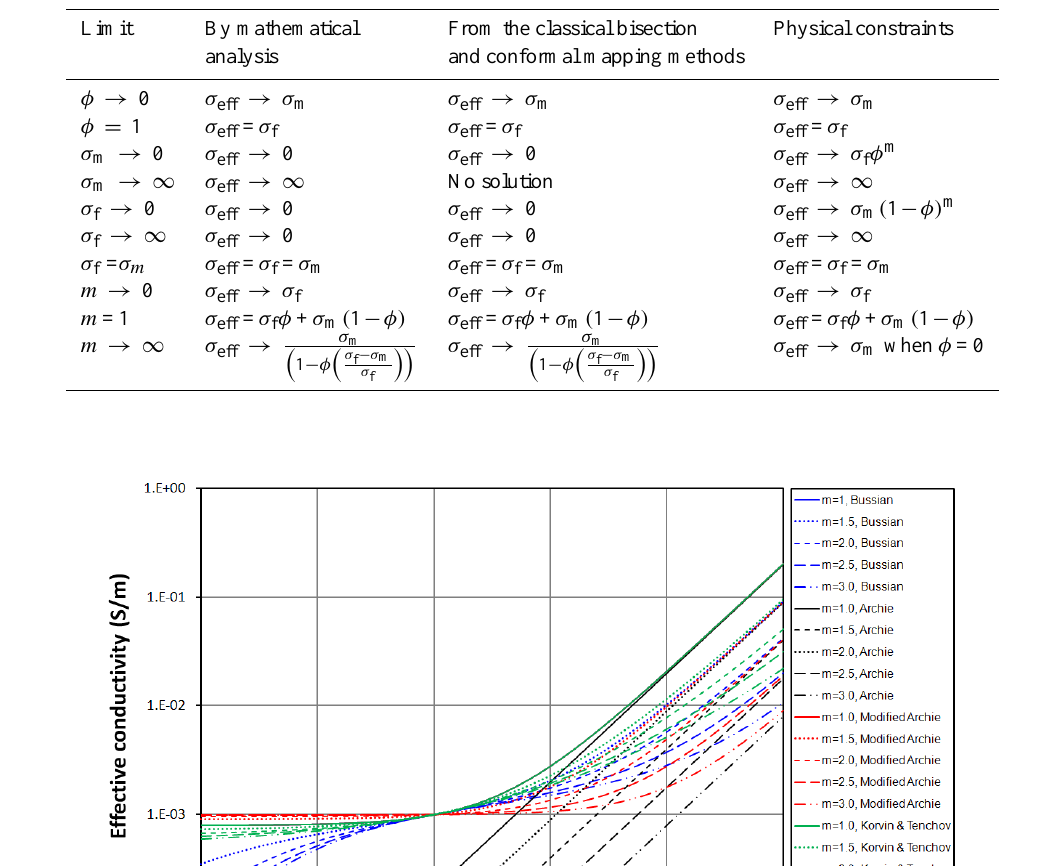
Table 1. Limiting values of the Bussian equation solutions.